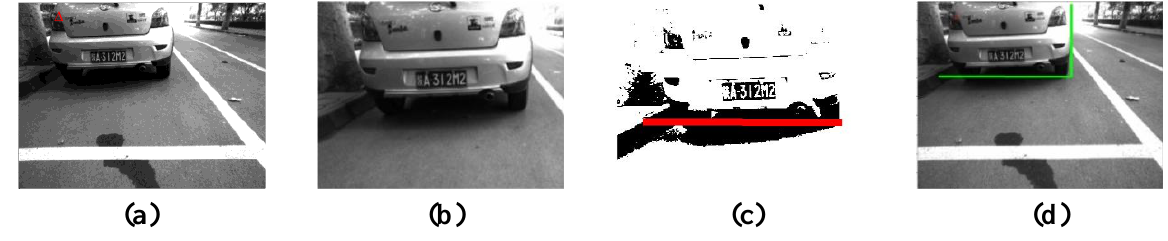
Figure 11. ( a ) Original experimental image; ( b ) Candidate searching region determination; ( c ) Shadow detection result; ( d ) Right border determination.